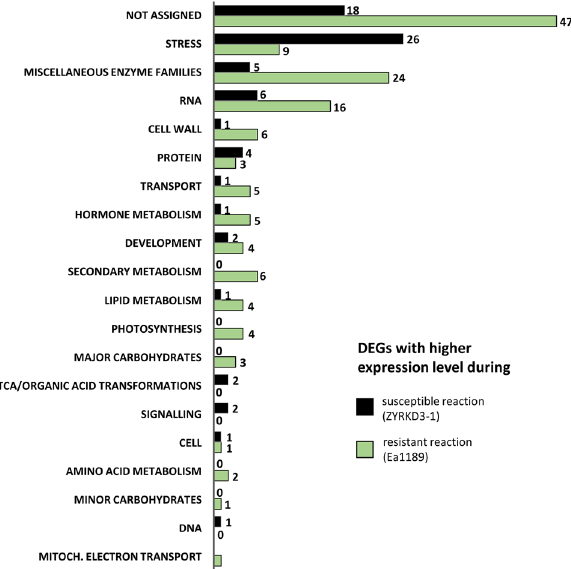
Figure 2. Functional categorization of differentially expressed genes in Mr5 during susceptible and resistant reaction to Erwinia amylovora . The functional categorization of genes (BIN) that were significant differentially expressed (DEGs) was performed by analysis with MapMan. The numbers of genes, which have a increased expression level during resistant reaction (after inoculation with Ea1189) or susceptible reaction (after inoculation with the avrRpt2 EA deletion mutant ZYRKD3-1), are depicted for each observed functional category. Figure 2 was created with Excel 2016 and PowerPoint